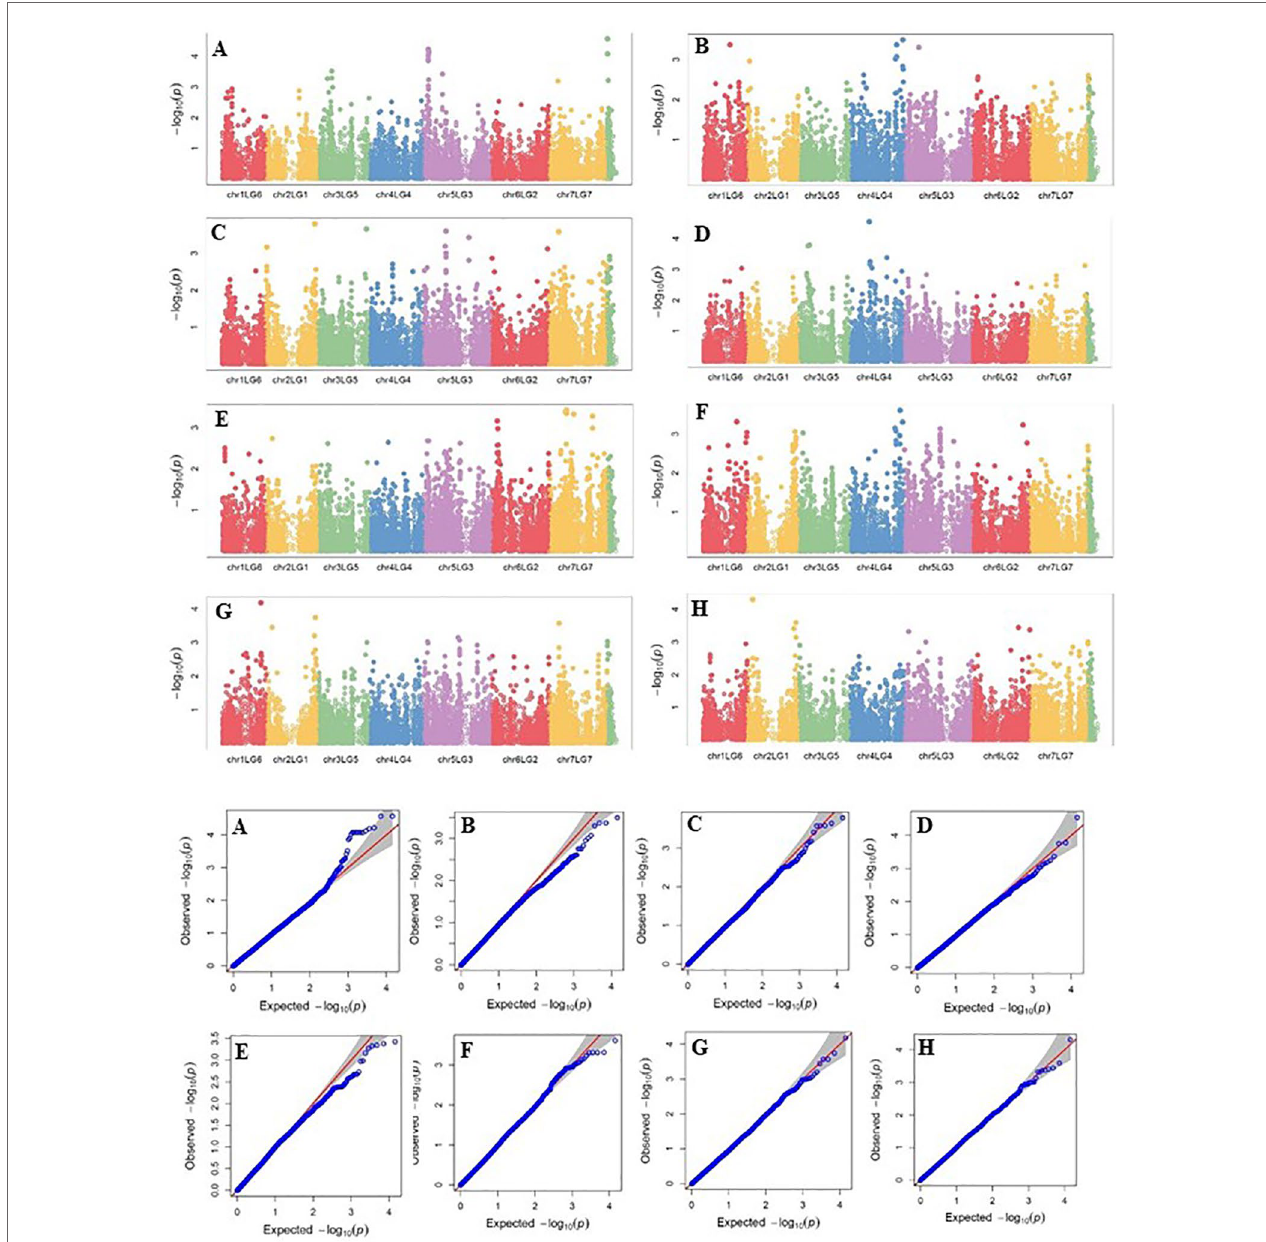
FiGUre 6 | Manhattan plots and the corresponding Q-Q plots representing the identification of SNP markers associated with lodging resistance in multiple trials. (A) 2013 Fargo, (B) 2014 Fargo, (c) 2014 Sutherland, (D) 2015 Fargo, (e) 2015 Sutherland, (F) 2016 Rosthern, (G) 2016 Sutherland, and (h) 2017 Sutherland. The Manhattan plots are based on association of 15608 chromosomal and 1269 non-chromosomal SNPs with the lodging score measured on a 1-9 rating scale (1 = upright